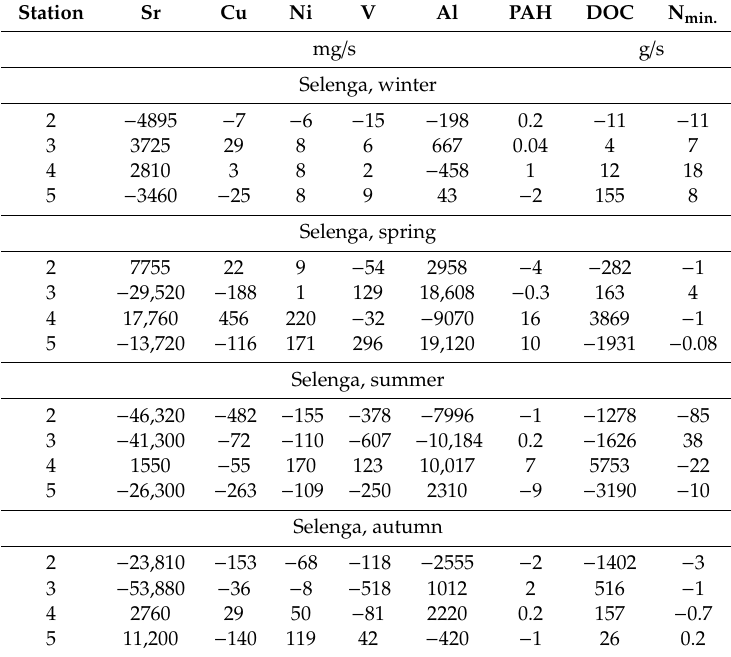
Table 4. Rates of contaminant removal from the Selenga